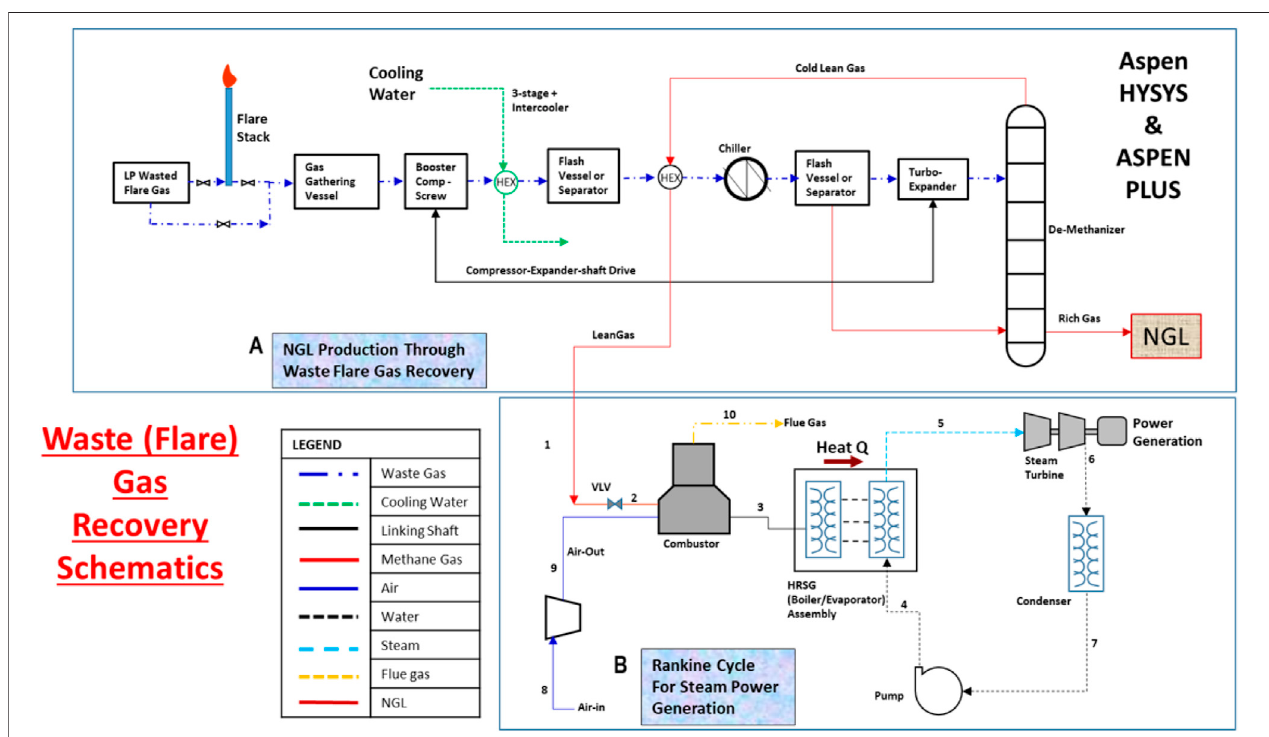
FIGURE 2 | Process schematics for the integrated waste gas to energy for [A], NGL recovery plant and [B] steam power generation plant.